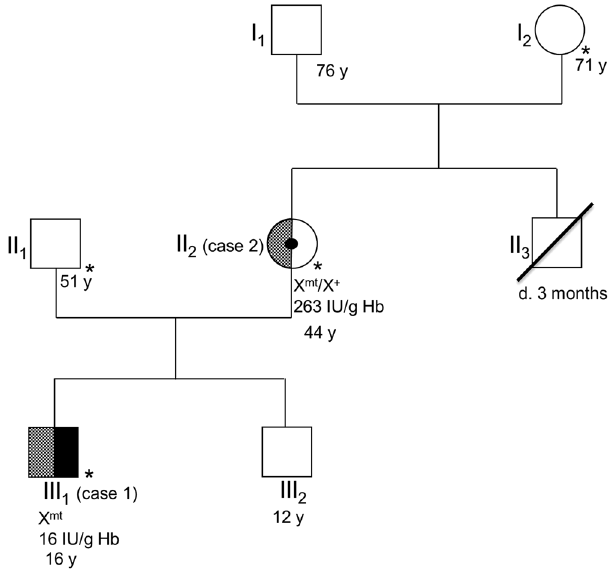
Fig. 1 The patient ’ s pedigree is presented in accordance with standardized human pedigree nomenclature. Solid black indicates the phenotype of classical symptoms of PGK-1 de fi ciency (i.e., hemolytic anemia and myopathy). The checkerboard pattern indi- cates the phenotype of parkinsonism. Members with asterisks were neurologically examined by the authors. Cases 1 (III 1 ) and 2 (II 2 ) were also genetically and enzymatically examined. The results of genetic and enzymatic testing for PGK-1 are presented below these cases. X mt and X + indicate an allele with the c.1060G > C mutation and the wild-type allele on the X chromosome,